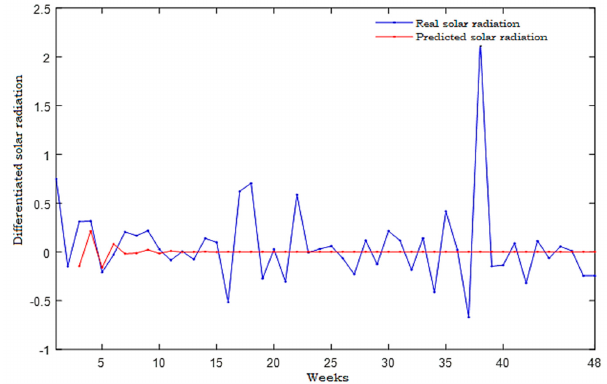
Figure 25. Solar radiation prediction using the ARMA (2,1) model.